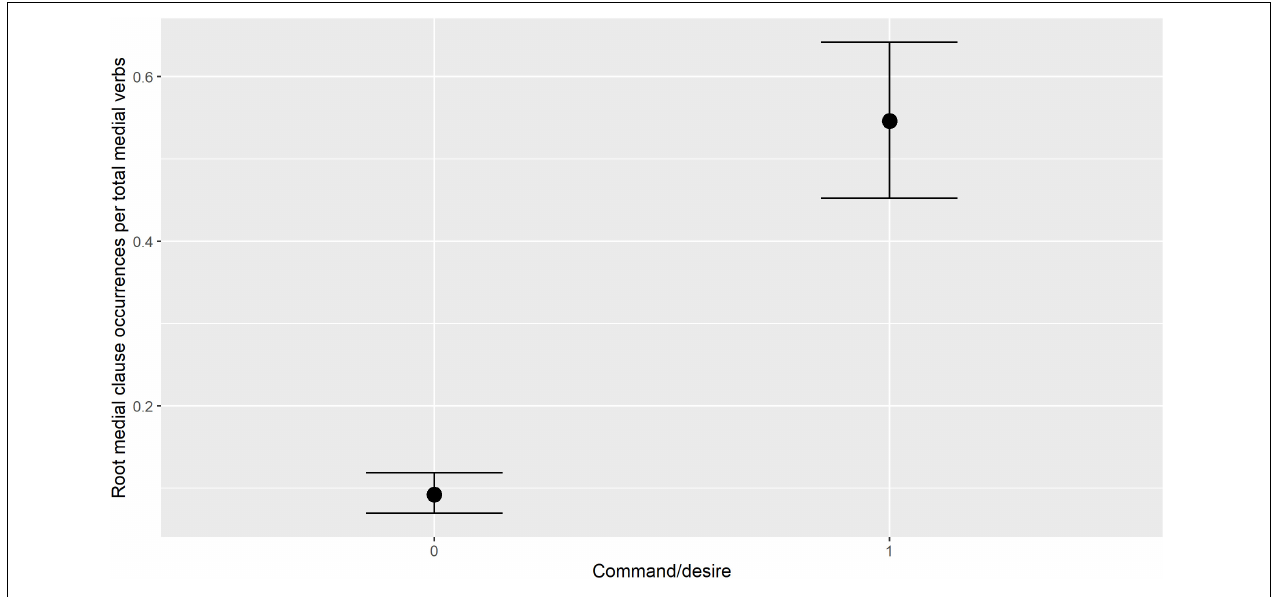
FIGURE 11 | Conditional effects of command/desire context on root medial clause occurrence.